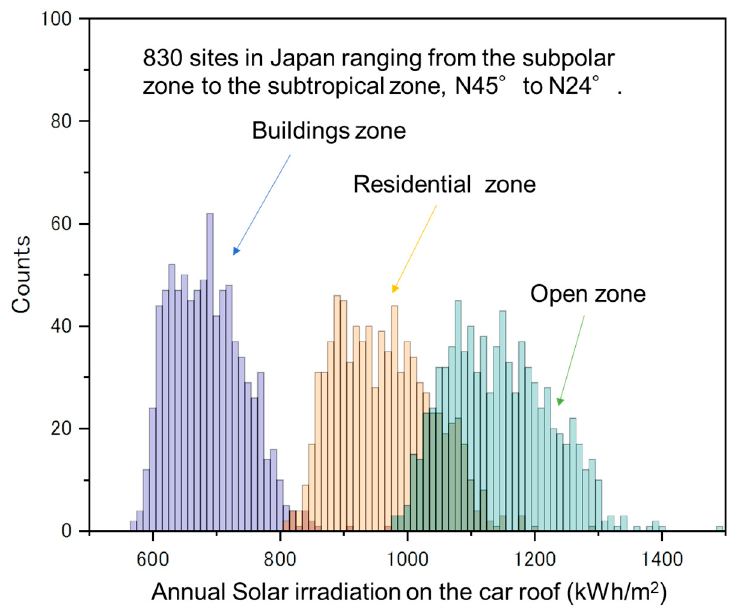
Figure 19. Histogram of the estimated solar irradiance on a car roof in Japan from 830 sites (N45° to N24°, ranging from subpolar to subtropical zone) in three zones.